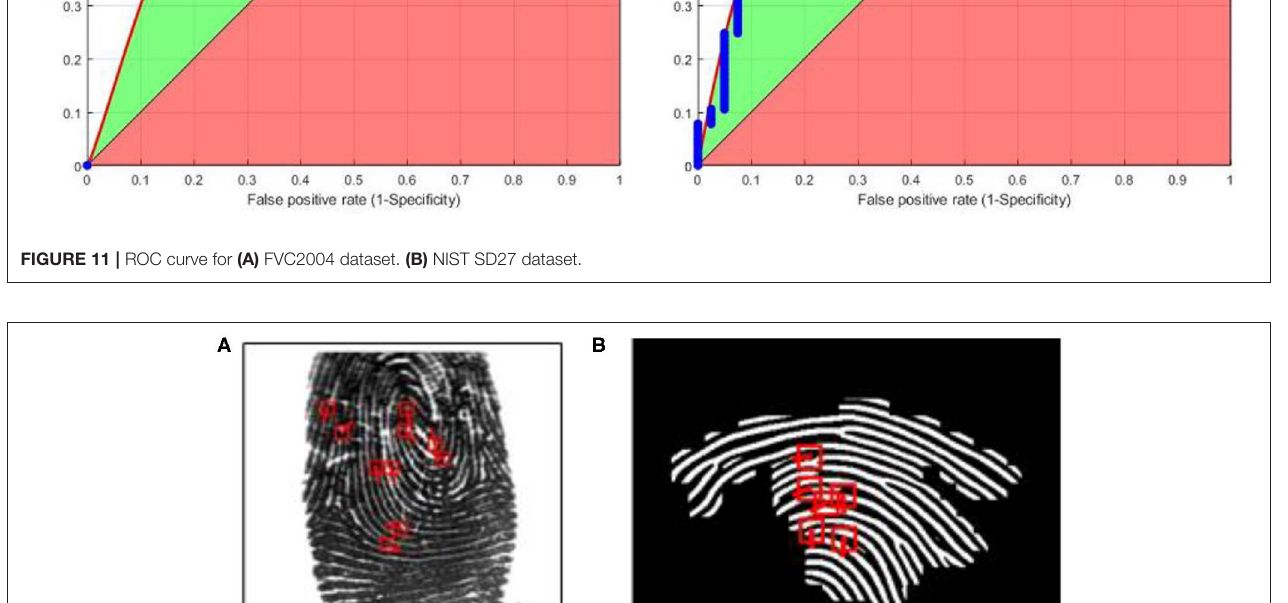
Frontiers in Robotics and AI |